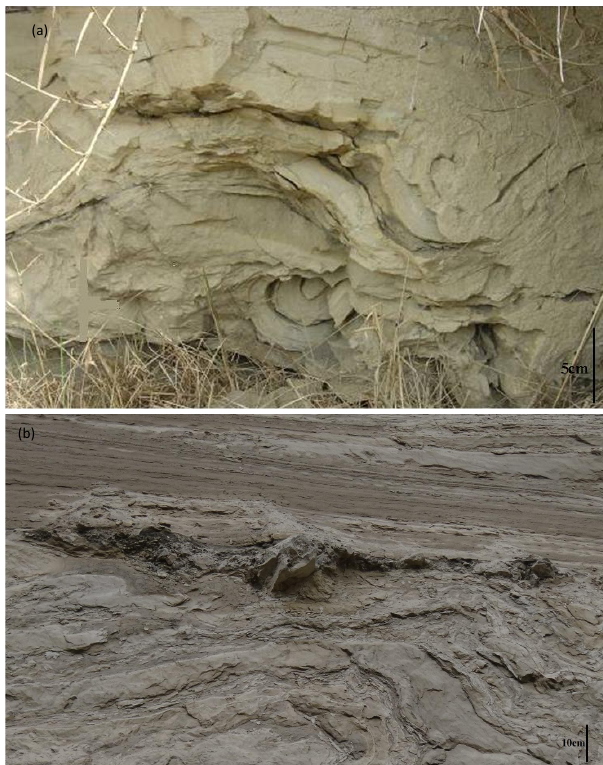
Fig. 11 . Earthquake-induced disturbance layer in the sediment exposed on an outcrop Figure 11. Earthquake-induced disturbance layer in the sediment exposed on an